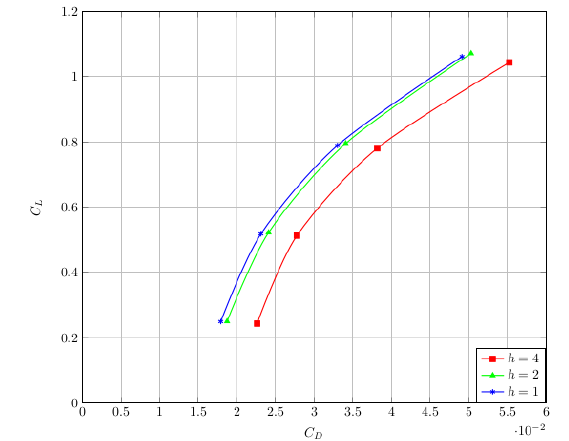
Figure 12. NLF wing body configuration: M ∞ = 0.64, Re ∞ = 18.2 × 10 6 . Lift-drag polar curves obtained on three grid levels